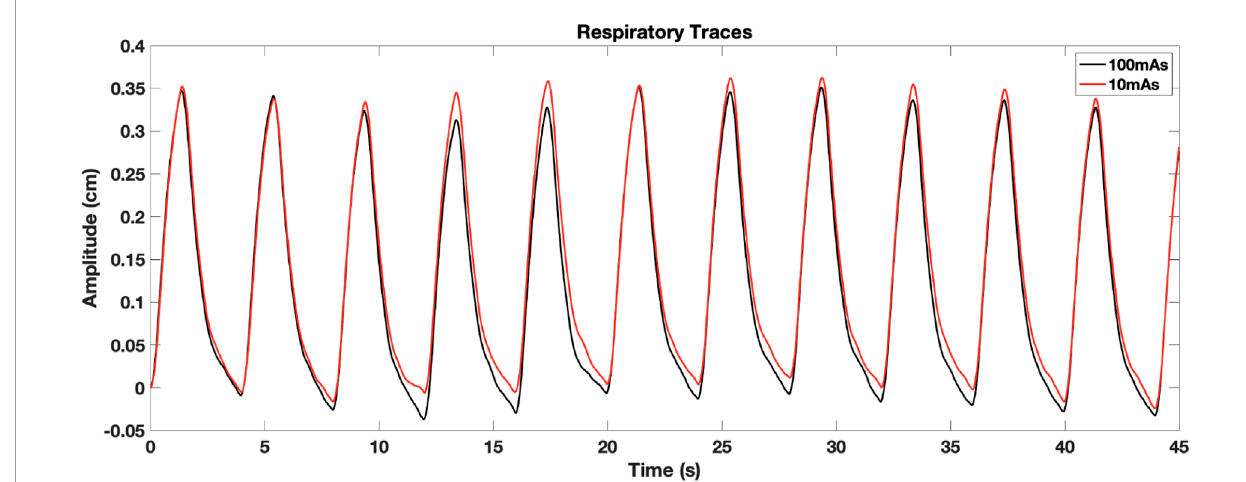
FIGURE 5 RPM breathing traces for consecutively acquired 4DCTs are shown.